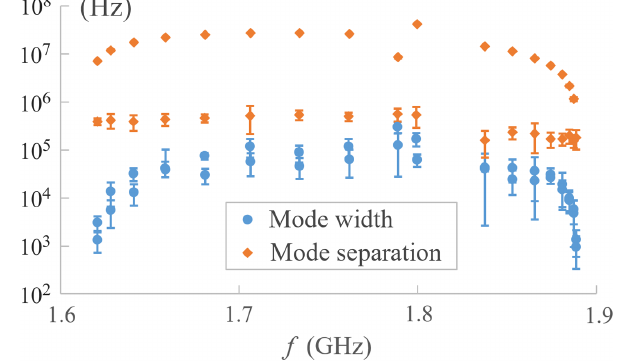
FIG. 4. Mode separation compared to mode width for the lowest two dipole passbands in MESA cavity.